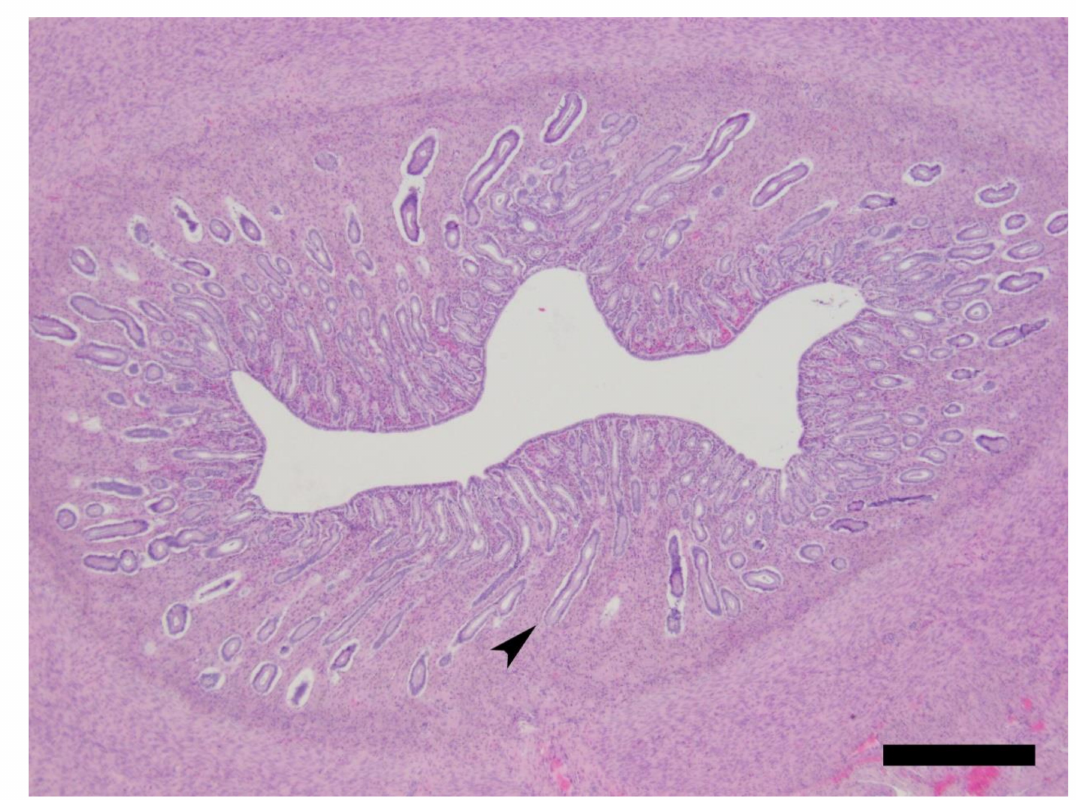
Figure 6. Feline uterine horn. The endometrium demonstrates elongated long glands (arrowhead), which are characteristic of the luteal stage. H&E stain. Bar = 500 µ